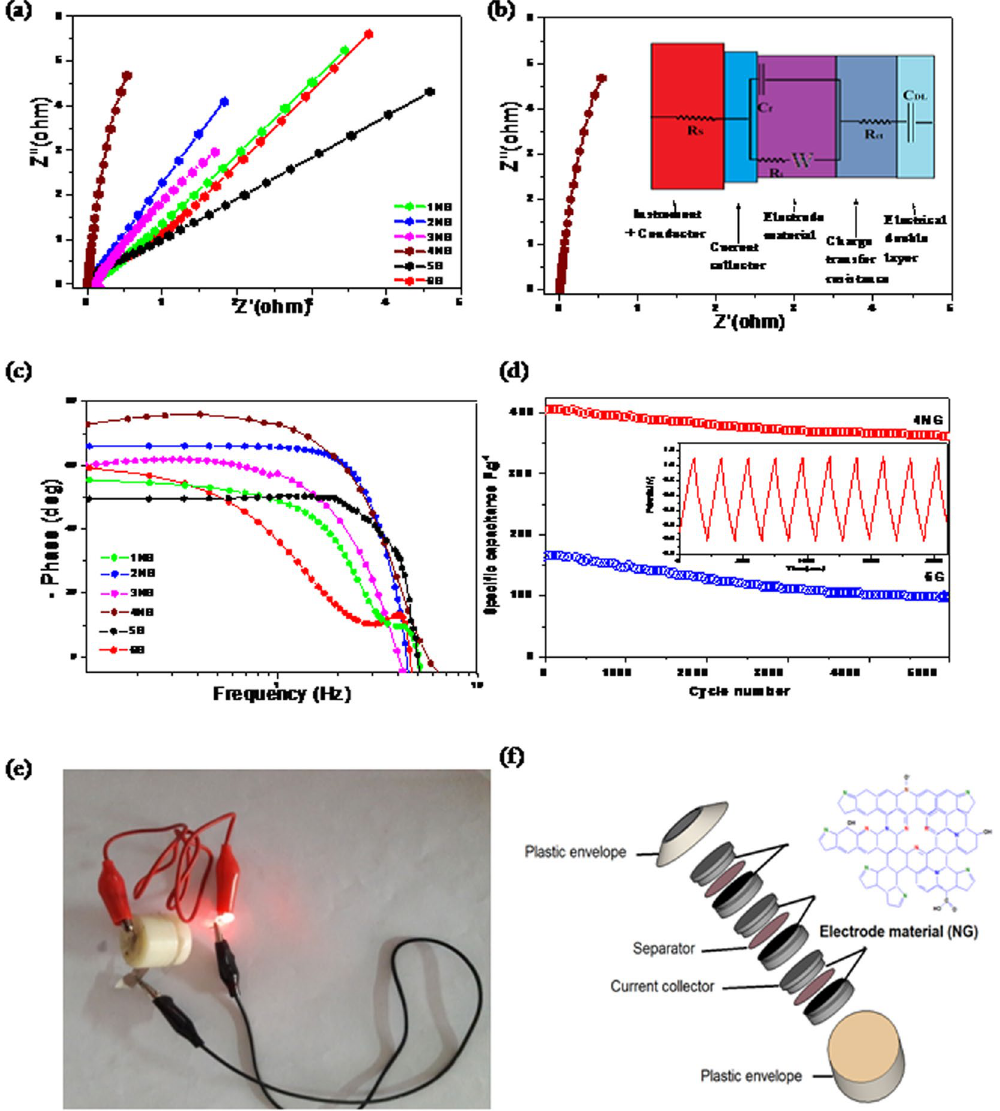
Figure 4. ( a ) Nyquist curves for all prepared samples as electrodes in 6 M KOH, ( b ) Nyquist curve of 4NG sample (inset shows its equivalent circuit), ( c ) Bode plots of all prepared samples supercapacitor devises, ( d ) The cycling stability of sample 4NG supercapacitor and sample 6 G, during 5000 charge/discharge cycles, measured at a current density 4 A g − 1 within the potential range from 0 to 1.1 V, with the first 10 charge/discharge cycles for sample 4NG, ( e ) Photograph and ( f ) Schematic illustration of a stacking three-unit cell used to power a red